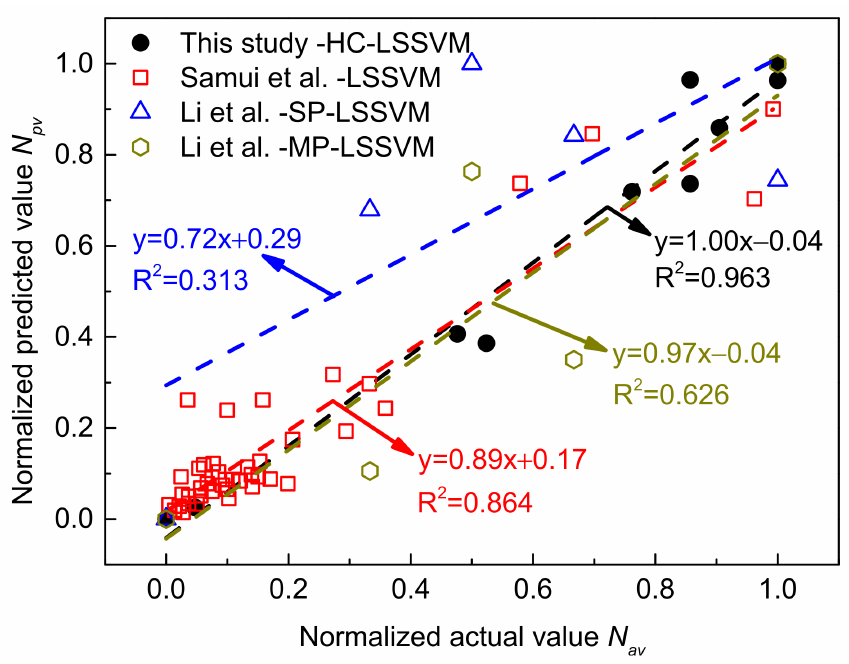
Figure 5. Comparison between the HC-LSSVM model and other research